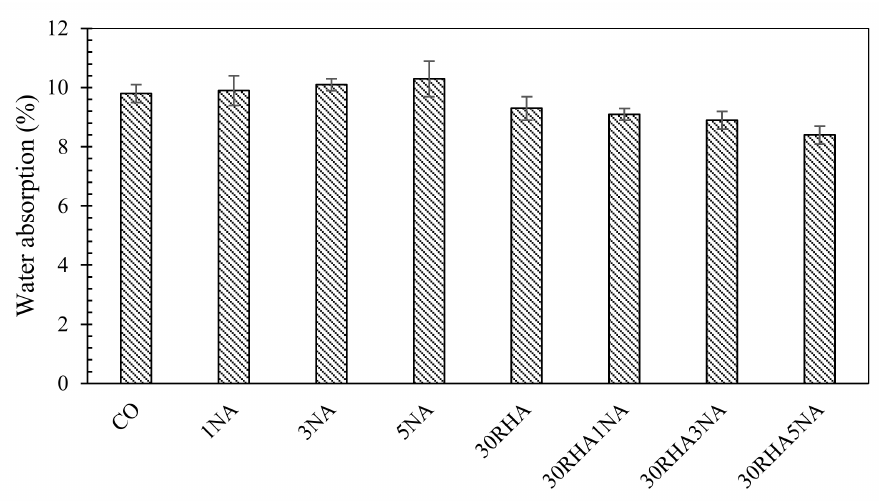
Figure 3. Water absorption rate of SC